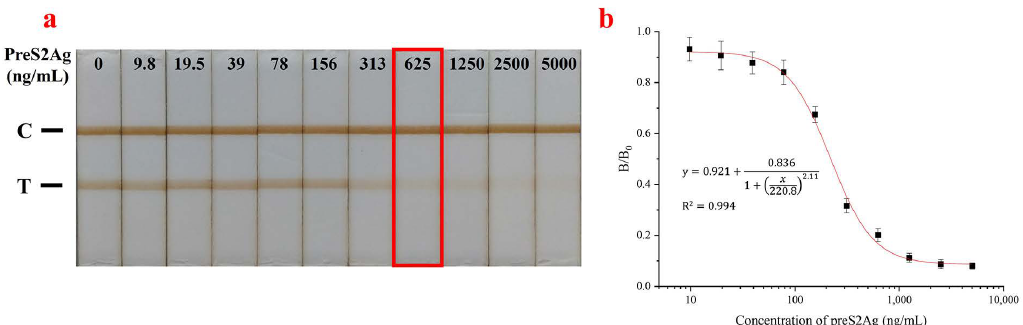
Figure 6. Detection sensitivity of the GAM-MNPs-ICA for preS2Ag detection. ( a ) Qualitative detection results. ( b ) Quantitative standard curve. The error bars represent the standard deviation of three repeats (n = 3).